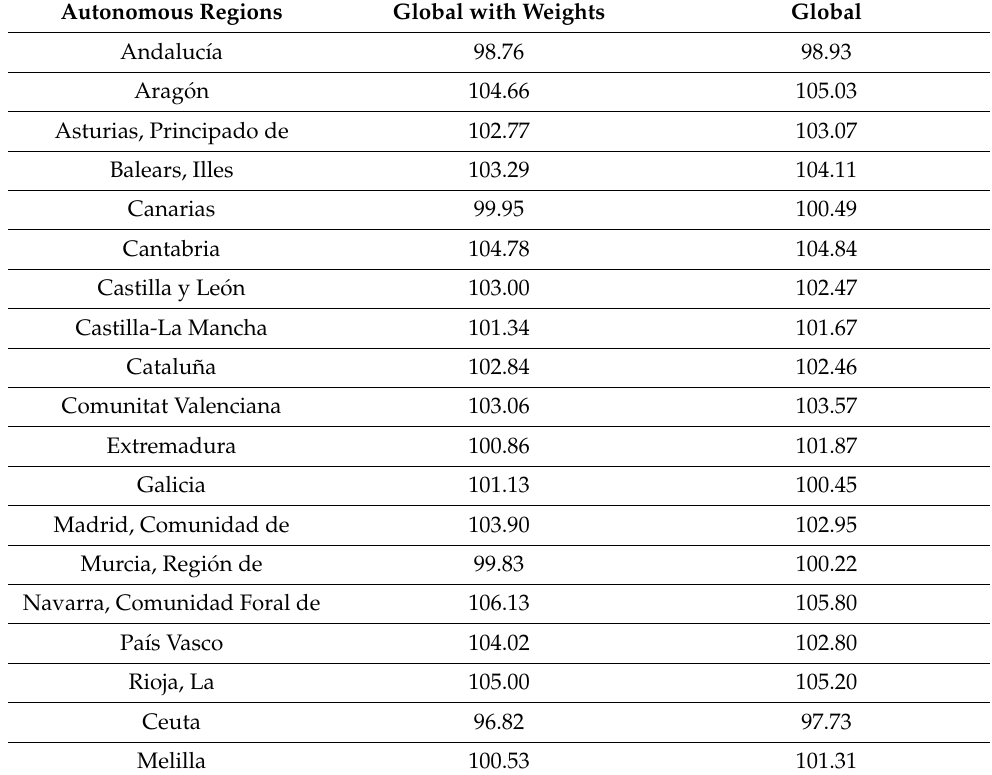
Table 13. Data used to create the Figure